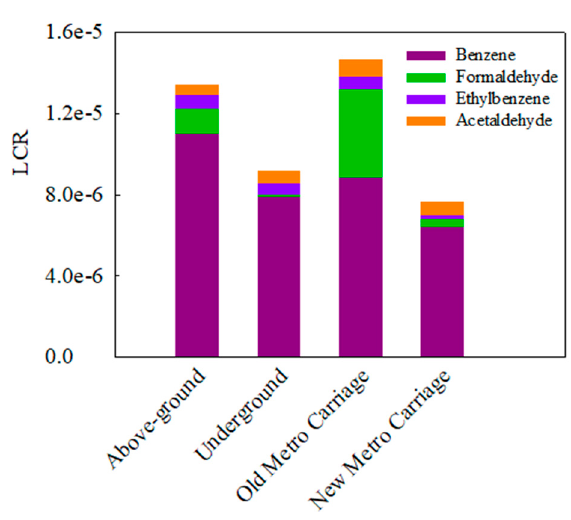
Figure 6. Life cancer risk (LCR) of VOCs in metro carriages under di ff erent conditions during 2015–2016. 2015 data is from Ref. [35].